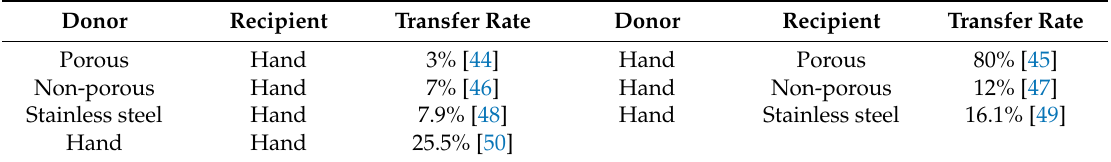
Table 4. 1 Virus transfer rate between hands and